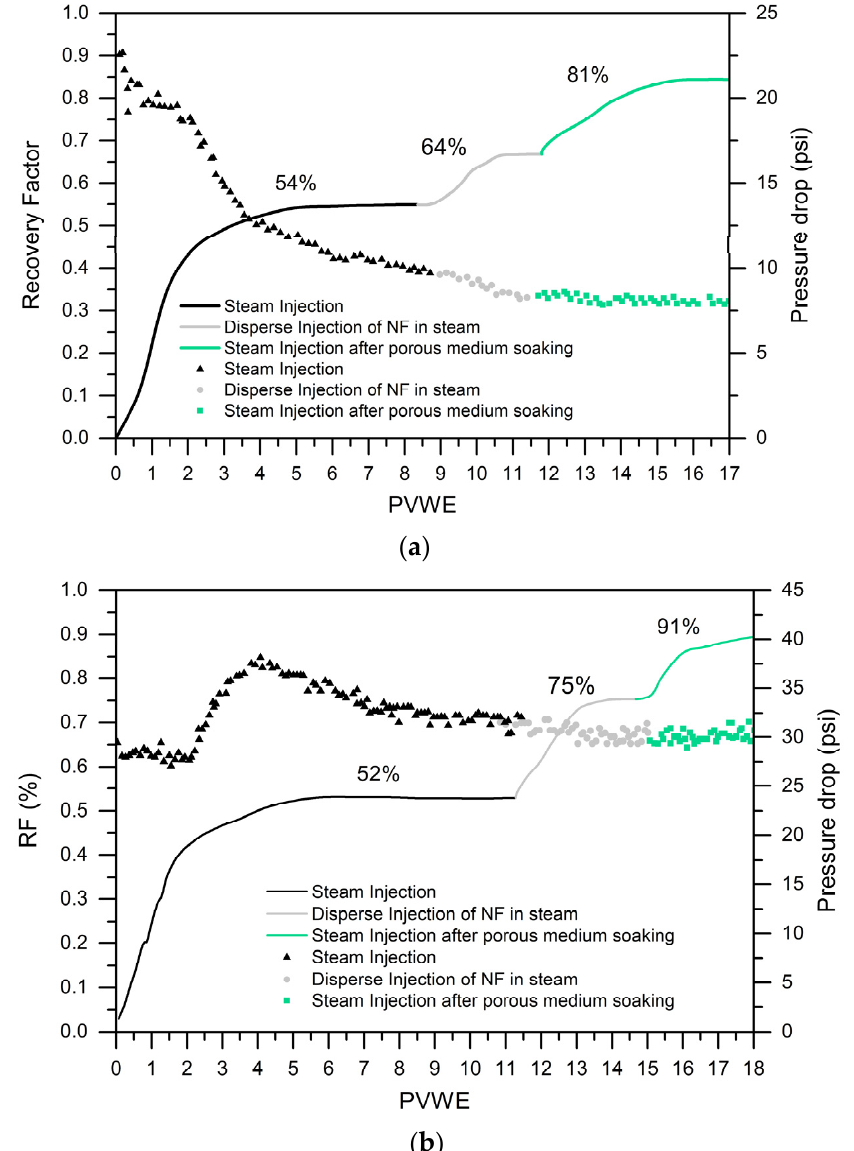
Figure 1. Oil recovery curve for steam injection assisted by Al-NF dispersed in the steam stream during the stages: (1) continuous steam injection, (2) dispersed injection of nanofluid in steam, and (3) steam injection after porous medium soaking in ( a ) HO1, and ( b ) HO2. Steam injection temperature: 270 °C for both cases. Pore pressure = 150 psi for both cases. Overburden pressure 1528 and 1992 psi for HO1 and HO2, respectively.